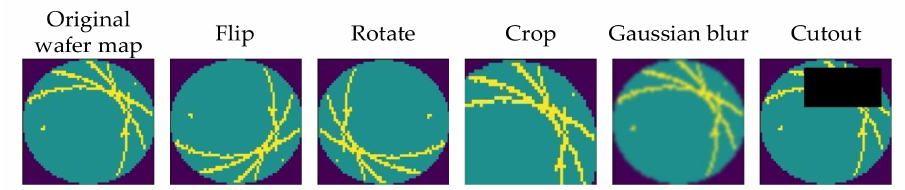
Figure 14. Augmentation based on image transformation.